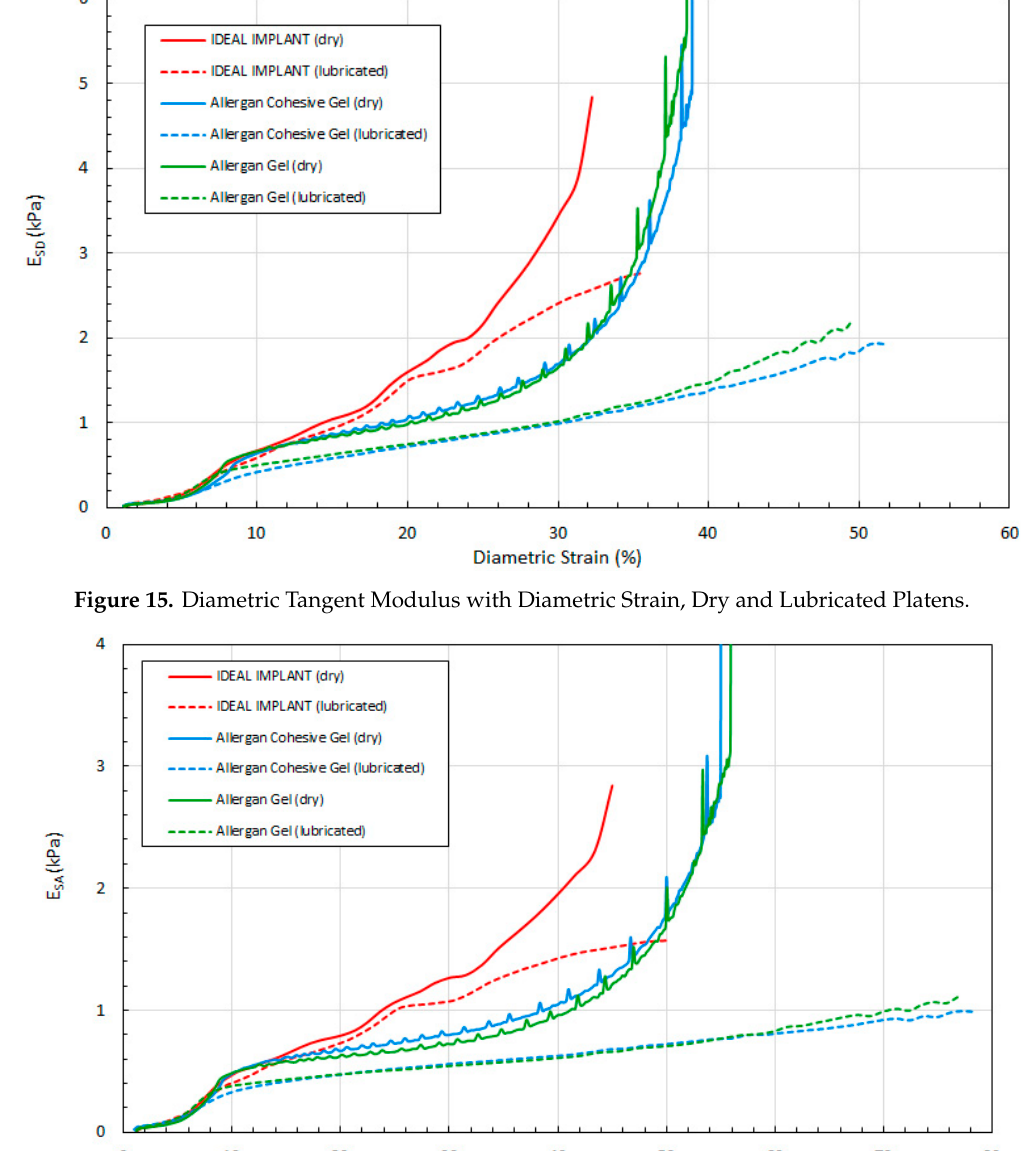
Figure 16. Areal Tangent Modulus with Areal Strain, Dry and Lubricated Platens.